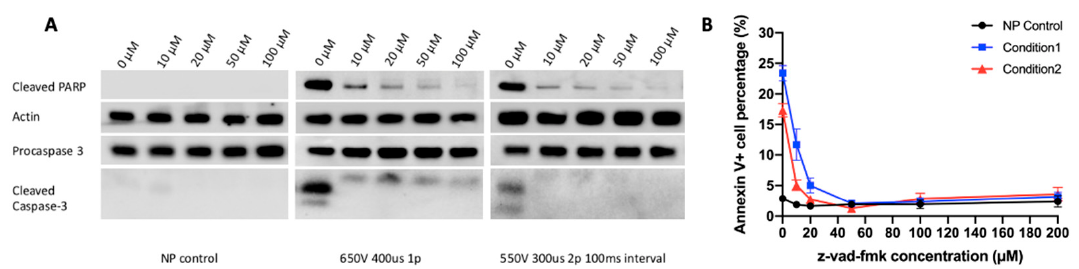
Figure 3. Percent of apoptotic cells after treatment with pharmacological inhibitor. Cells were treated with z-vad-fmk at different concentrations for 8 h post pulsing. ( A ) Western blot analysis at 8 h post pulsing. ( B ) Percent of apoptotic cells (Annexin V+). N = 6. NP, non-pulsed. Two pulsing conditions were tested. Condition 1: 650 V/0.2 cm, 400 µs, 1 pulse; Condition 2: 550 V/0.2 cm, 300 µs, 2 pulses, 10 Hz. Error bars, SEM.